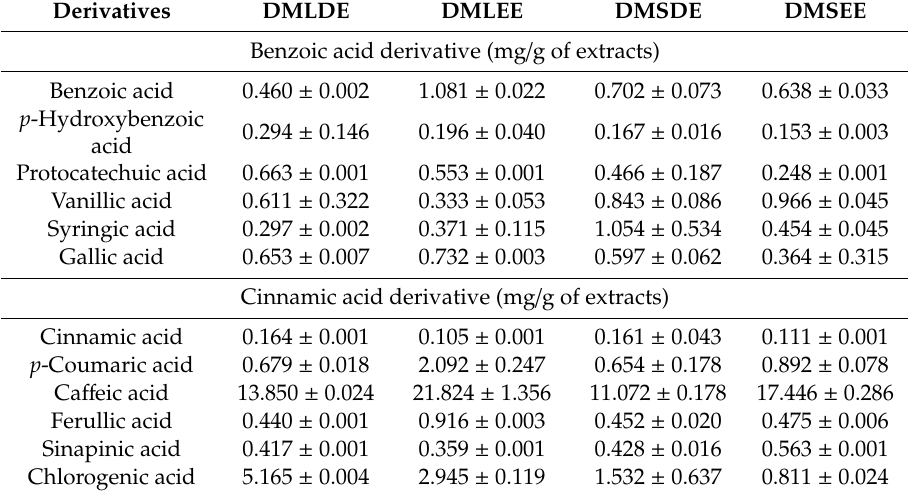
Table 2. Individual phenolic acid contents in the Dendropanax morbifer leaf and stem extracts (unit: ug / g of